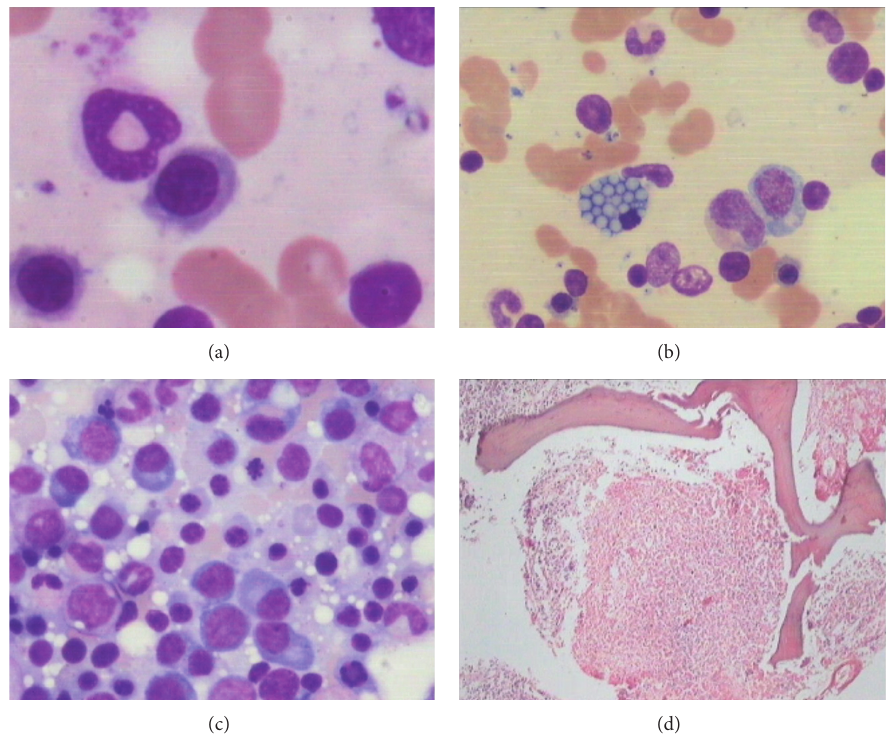
Figure 2: (a) bone marrow aspirate showing dysmyelopoiesis in a case of leishmaniasis, (b) bone marrow aspirate showing plasma cell with grape cell morphology and LD body, (c) bone marrow aspirate showing erythroid hyperplasia with increased plasma cells in leishmaniasis (Jenner Giemsa; × 1000), and (d) bone marrow trephine biopsy showing granuloma and focal necrosis in a case of leishmaniasis (hematoxylin eosin; × 100).